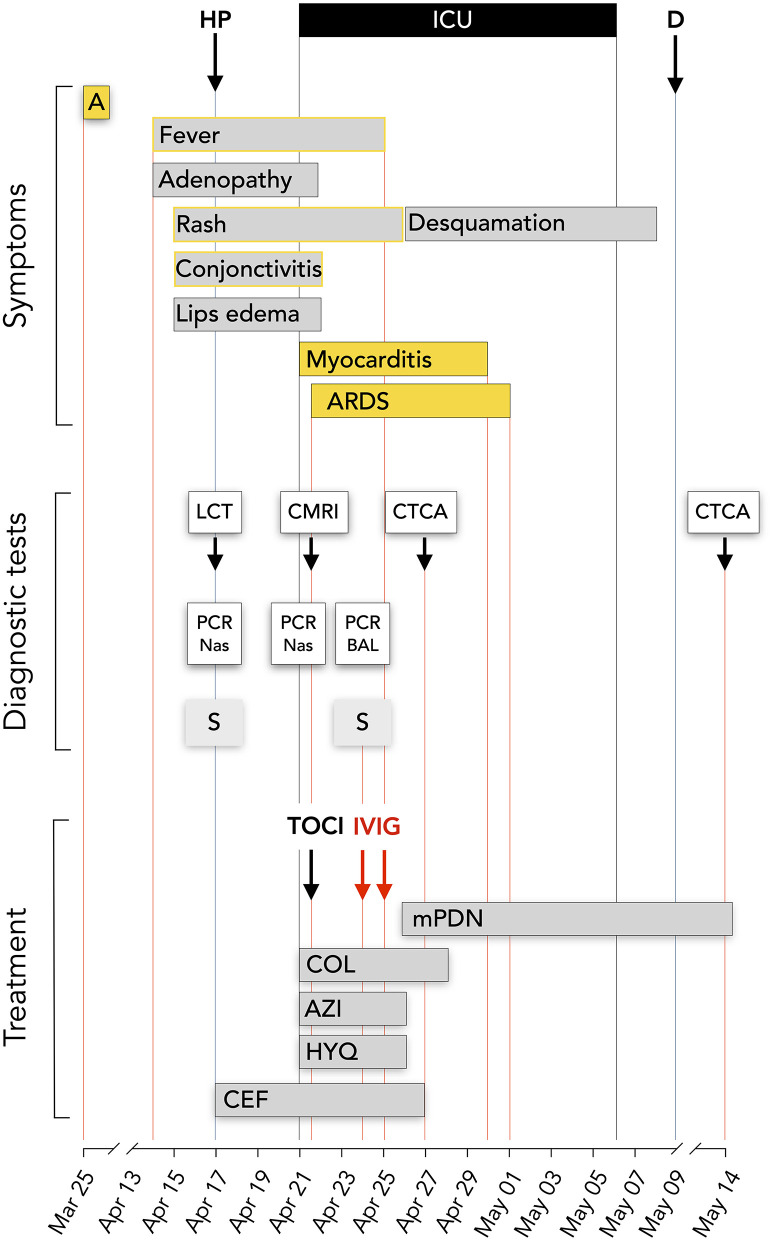
Time line. Symptoms, diagnostic tests and treatment. HP, hospitalization; ICU, intensive care unit; D, discharged day; A, transient anosmia; LCT, lung computed tomography; CMRI, cardiac magnetic resonance imaging; CTCA, computed tomography coronary angiography; PCR Nas, SAR-CoV-2 PCR on nasopharyngeal smear; PCR BAL, SAR-CoV-2 PCR on bronchoalveolar lavage; S, SAR-CoV-2 serology; HYQ, Hydroxychloroquine 400 mg bid during 2 days and then 200 mg; AZI, Azithromycine 500 mg on day 1 than 250 mg/day; COL, Colchicine 0.5 mg bid; mPDN, methyprednisolone 60 mg IV bid initially, 48 mg oral dose at discharge; 24 mg at May 14; CEF, ceftriaxone 2 g/d; TOCI, tocilizumab IV 480 mg; IVIG, Privigen 60 g.